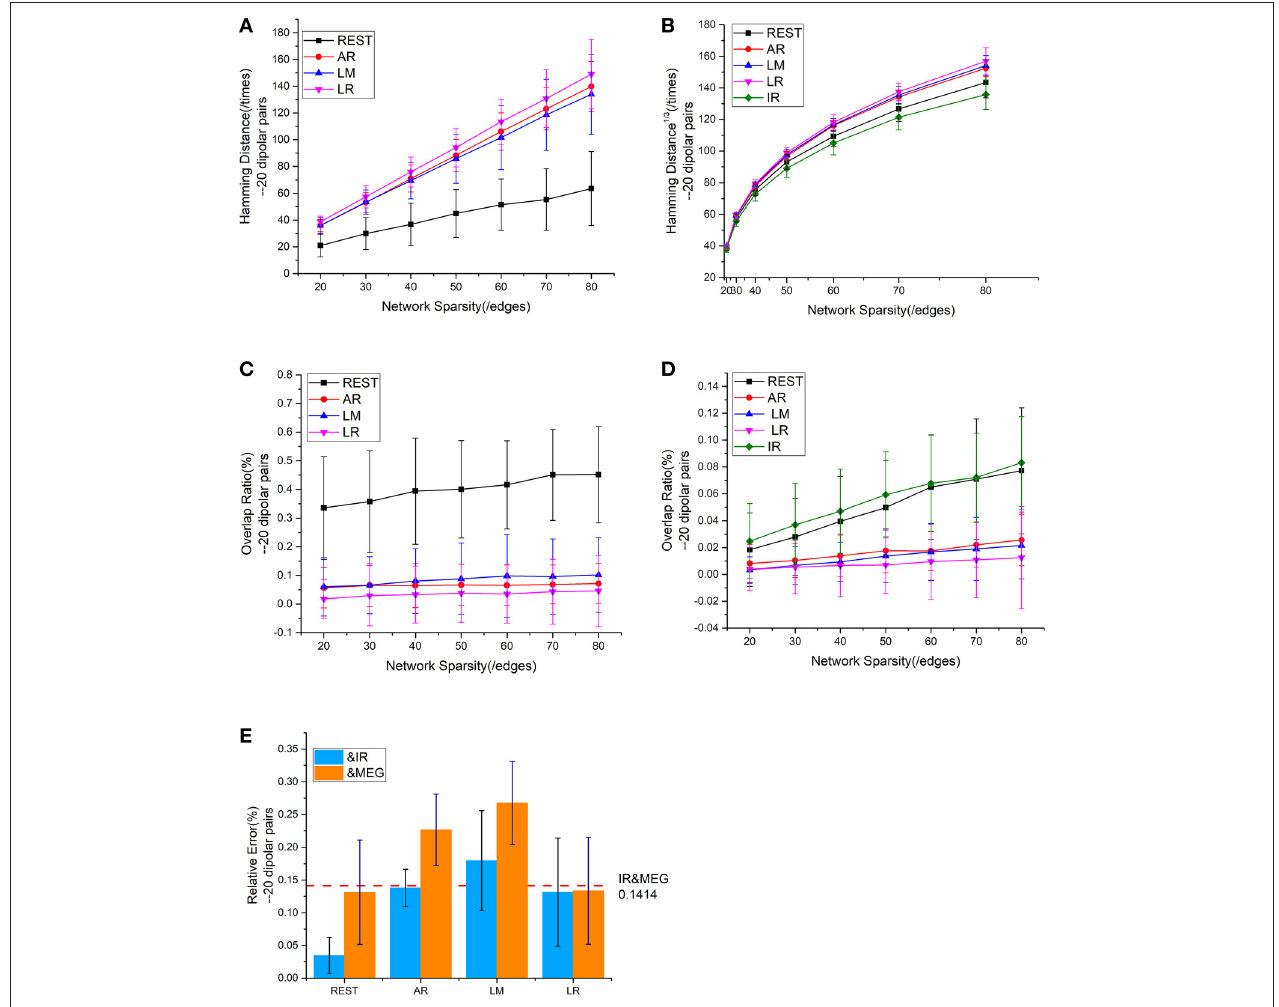
FIGURE 5 | Results using 20 dipolar pairs with different network sparsities. (A) HD (Hamming Distance) between each EEG reference and the EEG IR at different network sparsities. (B) HD between each EEG reference and MEG at different network sparsities, including the HD between EEG IR and MEG. (C) OR (Overlapping Rate) between each EEG reference and the EEG IR at different network sparsities. (D) OR between each EEG reference and MEG at different network sparsities, including the HD between EEG IR and MEG. (E) RE (Relative Error) between each EEG reference and two standards (MEG and the EEG IR). RE between IR and MEG (the red dash line) stays the same at different network